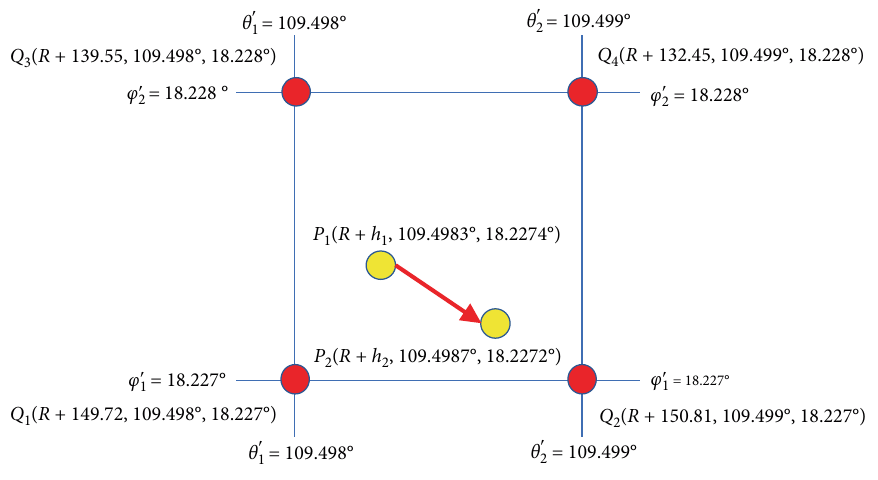
Figure 8: Schematic diagram of the